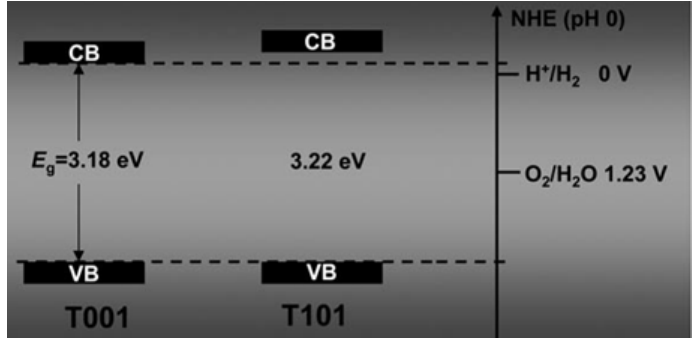
Figure 15. Schematic resolved band structures of {001} and {101} anatase crystal facets. Adapted from ref. [109] with permission of